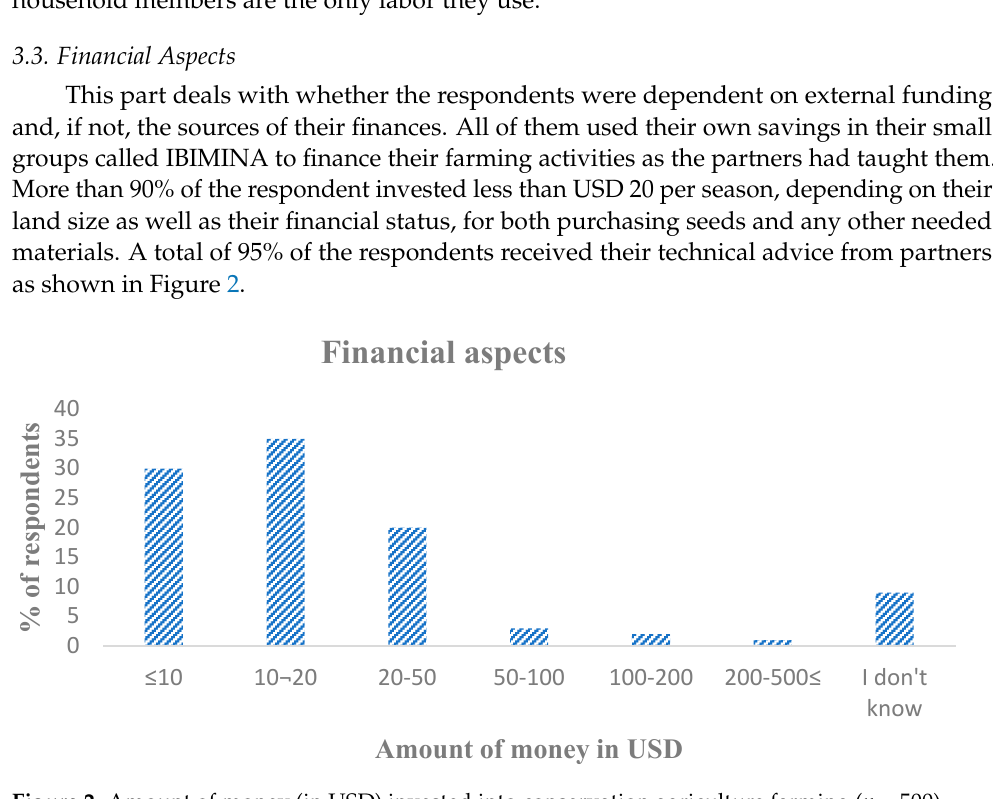
Figure 2. Amount of money (in USD) invested into conservation agriculture farming ( n = 500).